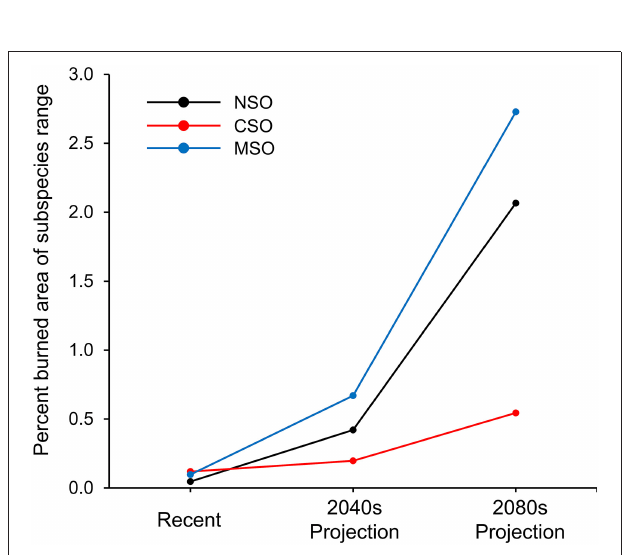
FIGURE 2 | Trends in total percent of the range of the spotted owl burned annually by subspecies and time period. NSO, Northern spotted owl; CSO, California spotted owl; MSO, Mexican spotted